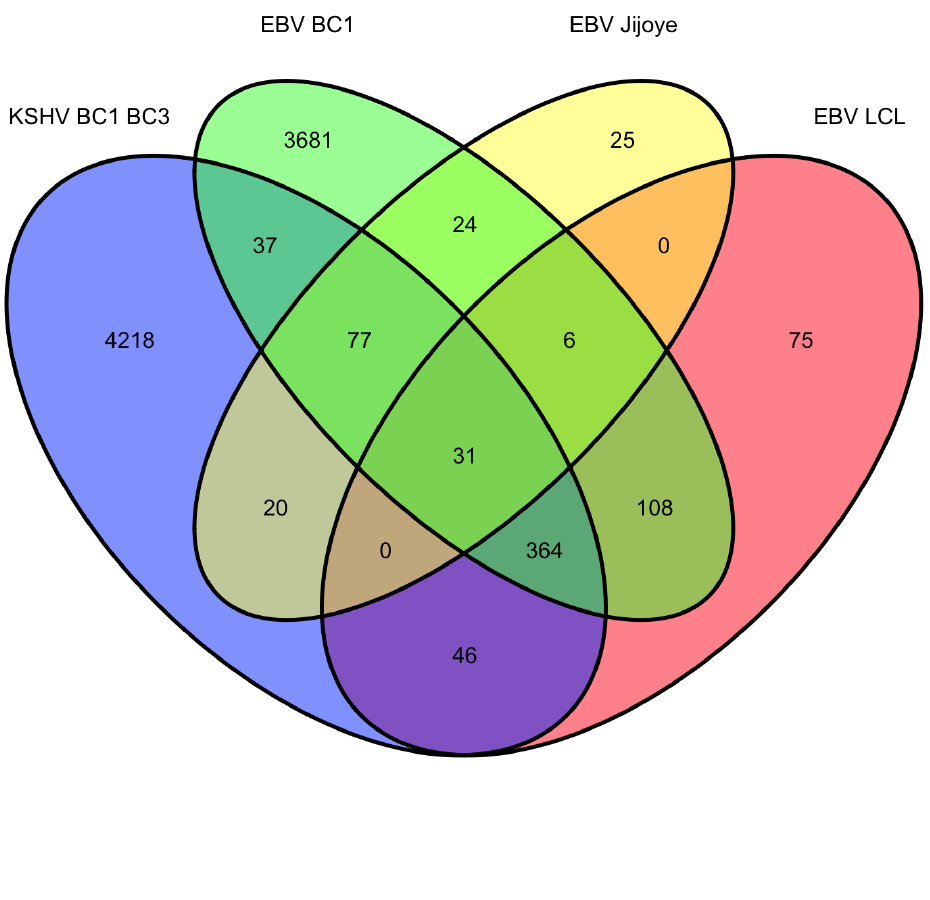
Figure 2. Venn diagram of BC1 predicted miRNA targets from Gottwein et al.